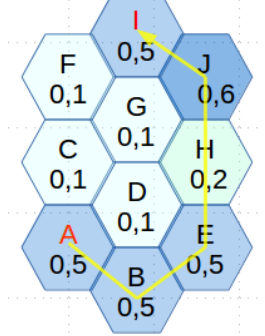
Figure 2. Example of a path from the origin A to the destination I where the shortest path with high packet delivery rate is (A, B, E, H, J, I)